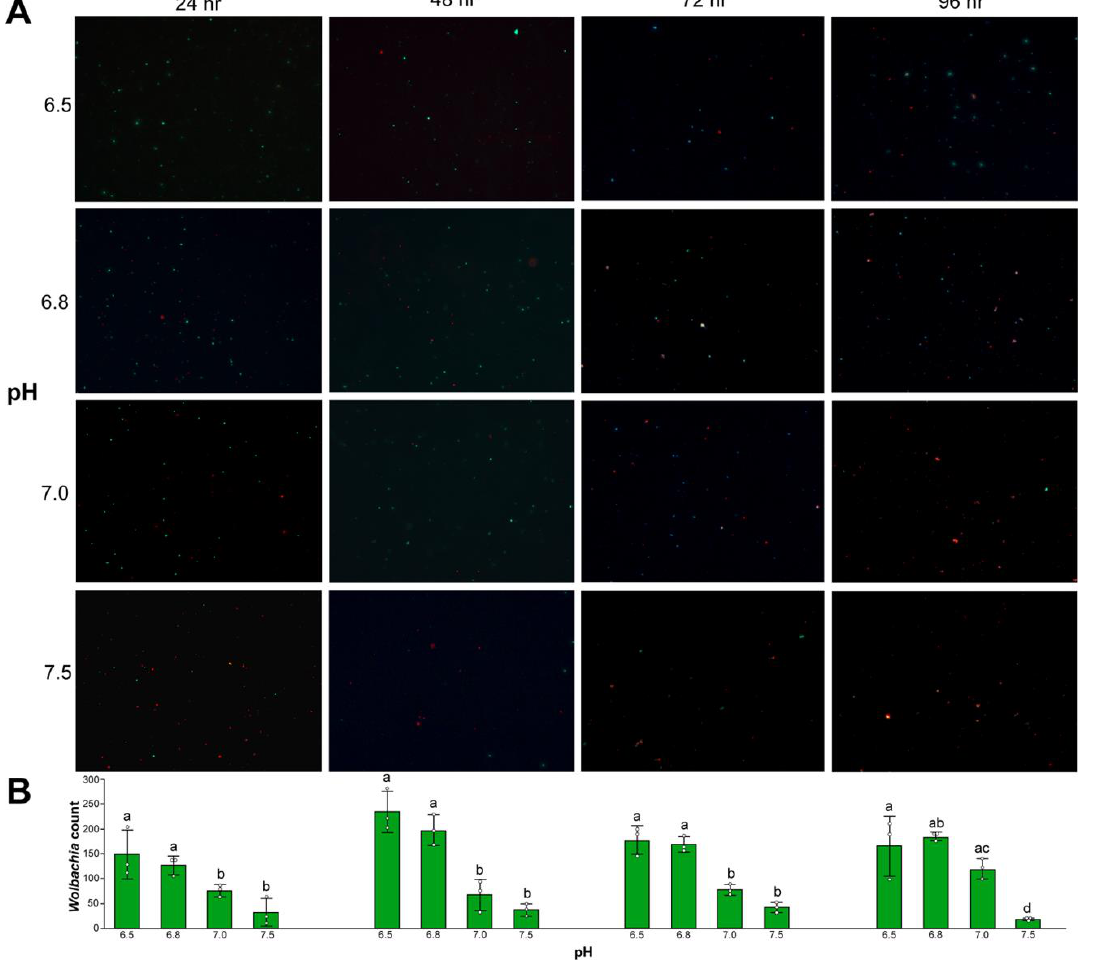
Figure 7. ( A ) Isolated Wolbachia stained with Baclight LIVE / DEAD ™ viability assays in Schneider’s medium supplemented with 10% FBS and an adjusted pH of 6.5, 6.8, 7.0, and 7.5. Live and dead Wolbachia are green and red, respectively. ( B ) Live Wolbachia was counted using Image-J from three representative fields of view at 100x. Significant di ff erences are indicated by di ff erent letters above each bar (Mann–Whitney, p < 0.05).